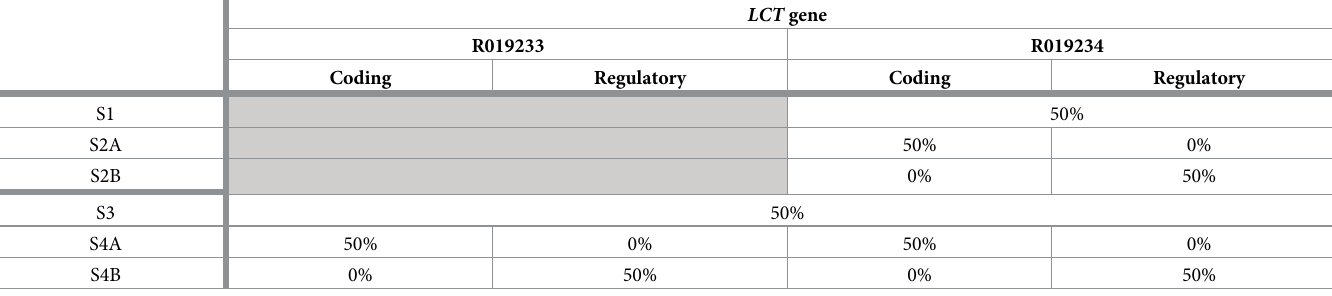
Table 2. Scenarios of association simulated to assess the performance of the RAVA-FIRST burden